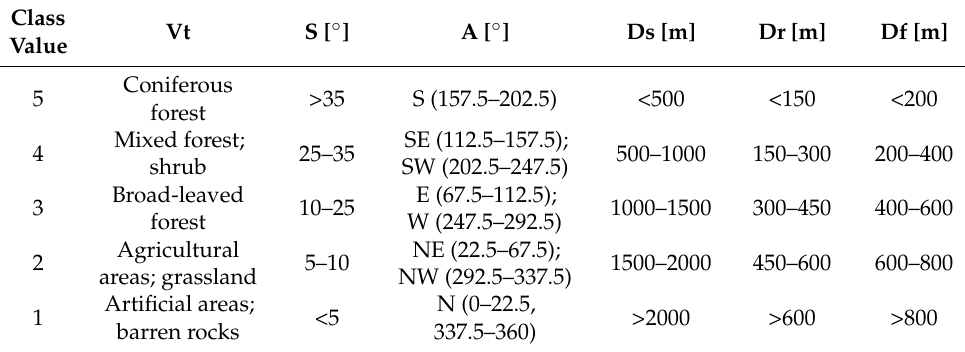
Table 1. Values of classes in